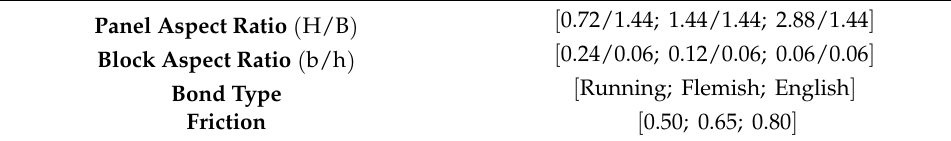
Table 1. Parametric analysis design: parameters’